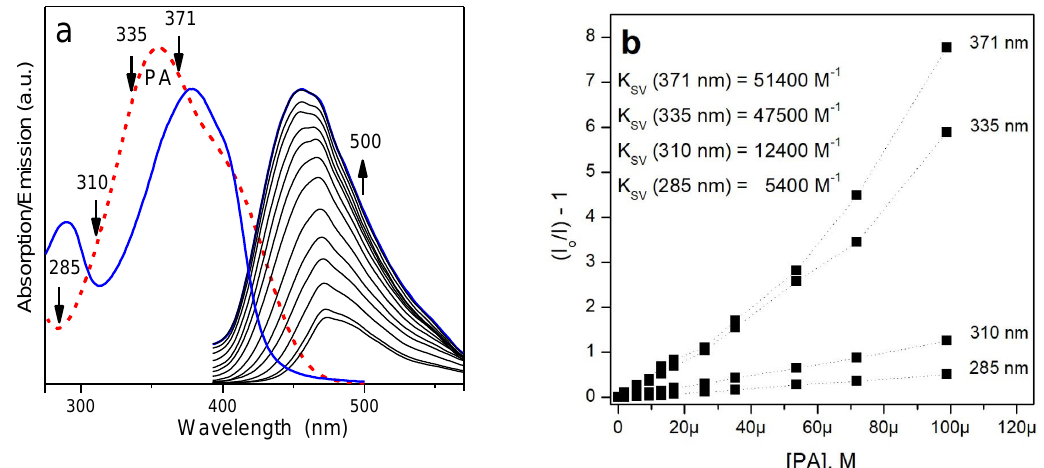
Figure 6. ( a ) Absorption spectrum of the picric acid in water (red dashed line). Absorption spectrum of a P26 film (solid line) and fluorescence spectra change ( λ exc = 371 nm) as a function of increasing concentrations of picric acid (PA) in water, fluorescence spectra were recorded 1 min after the quencher addition. Down arrows indicate the λ exc used to gather data presented in ( b ) while the up arrow indicates the λ em used to observe the fluorescence decrease. ( b ) The Stern–Volmer plots for a P26 film ( λ em = 500 nm) and PA obtained with λ exc = 285, 310, 335, and 371